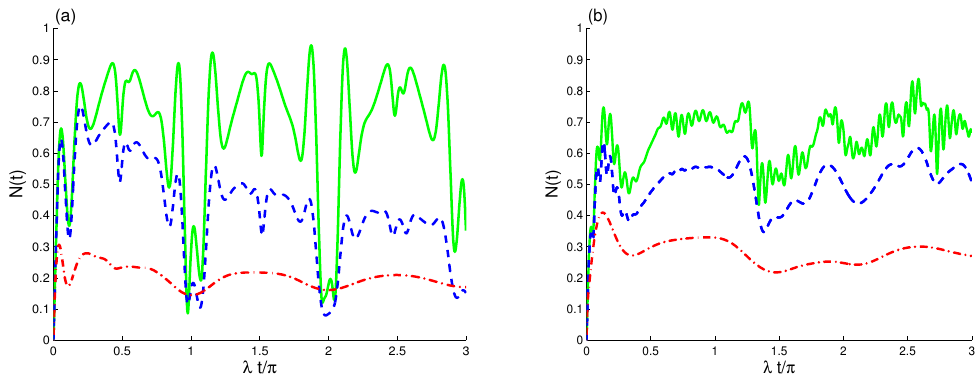
Figure 6. The N ( t ) for k = 1 and α = 5 with different decoherence values of γ : γ / λ = 0 (green solid 4 curves), γ / λ = 0.001 (blue dashed curves), and γ / λ = 0.03 (red dashed dot curves). With J / λ = 0 in ( a ) and J / λ = 30 in ( b ).